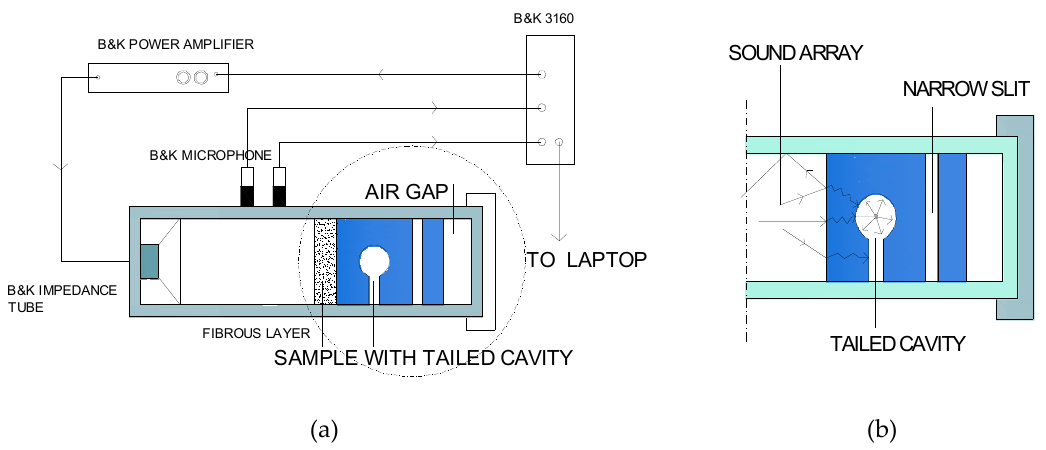
Figure 4. ( a ) The position of sample in the B&K impedance tube; ( b ) Sound trapping phenomenon in tailed cavity inclusion.